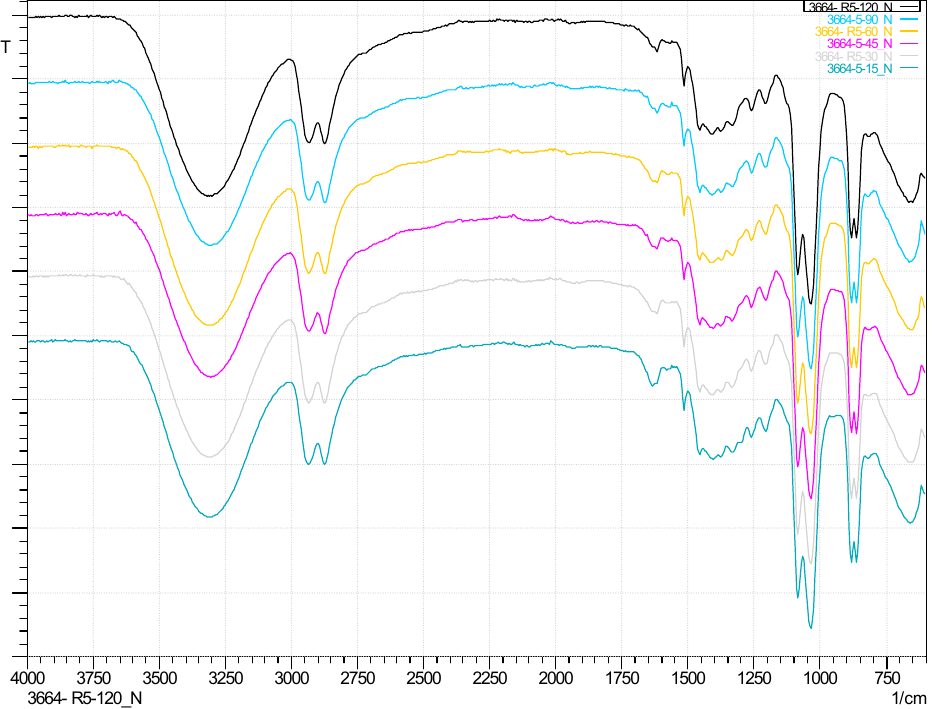
Figure 5. ATR ‐ IR spectrum of RPUF ‐ B glycolyzed products (200 ºC, EG, NaOH, 0.002 g/mol PUR) Figure 5. ATR-IR spectrum of RPUF-B glycolyzed products (200 ºC, EG, NaOH, 0.002 g/mol PUR) at at different times (15, 30, 45, 60, 90, and 120 min). different times (15, 30, 45, 60, 90, and 120